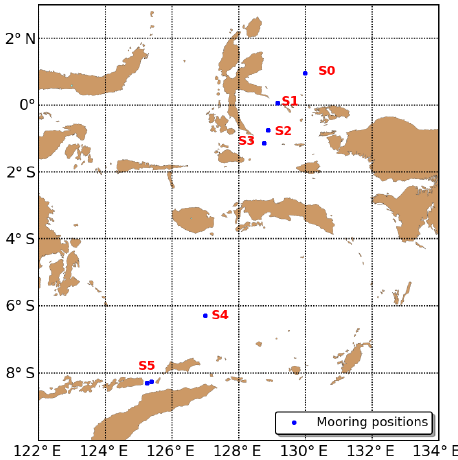
Figure 19. Locations of CTD moorings during the INDOMIX cam- paign (July